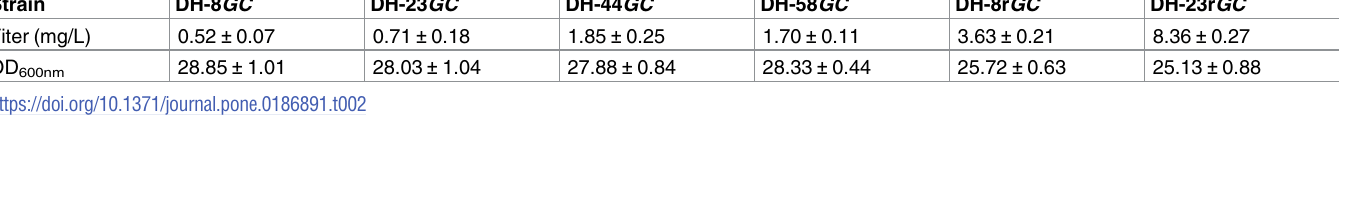
bination efficiency of 2.5–45% was achieved (Table 1). Additionally, the recombination effi- ciency was not correlated with either selection efficiency or the size of the targeted region (Table 1). The positive recombinants achieved in the second step depended on I-SceI cutting and DSB repair, with a selection efficiency of 31.6–94.4% (Table 1).